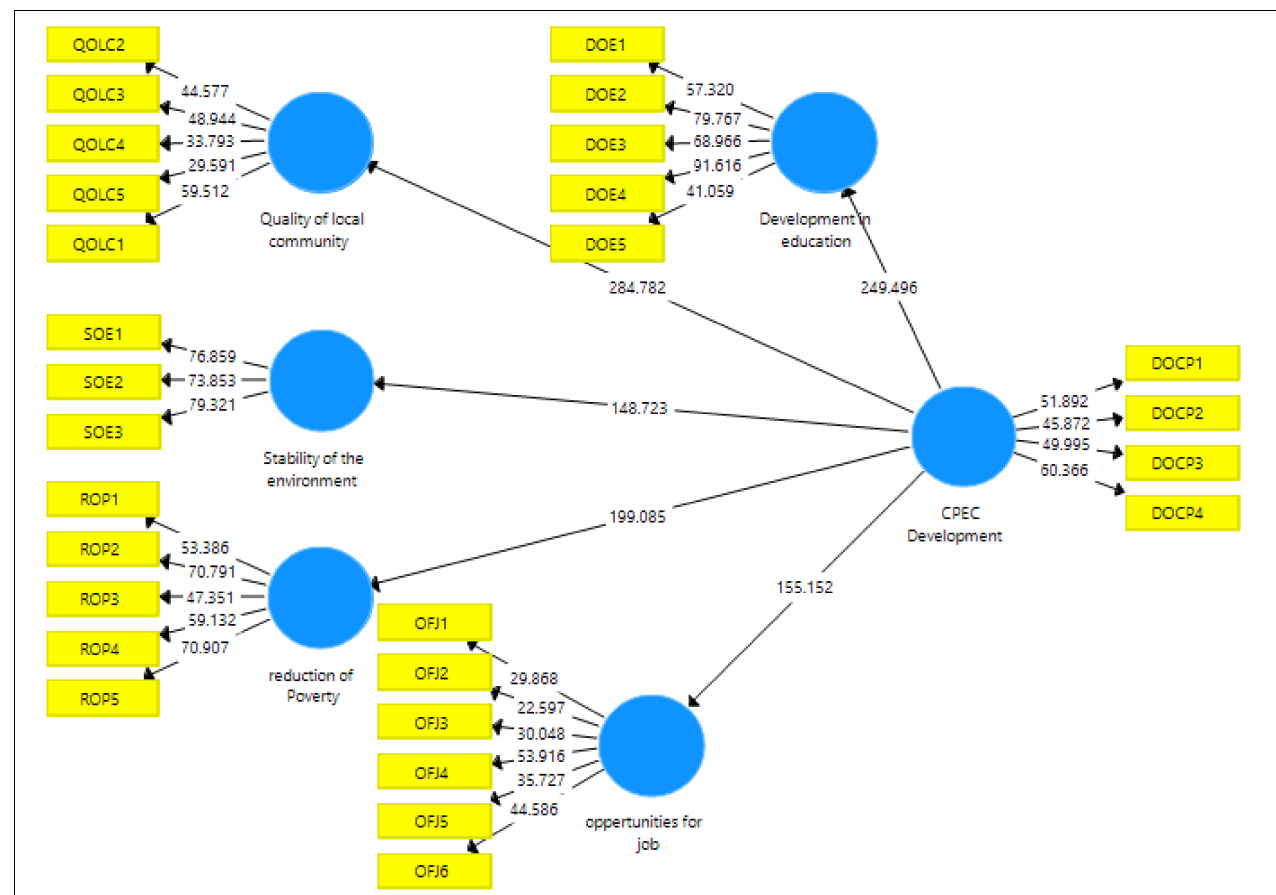
FIGURE 4 | Structural model of this study (the analysis based on PLS-SEM bootstrapping).